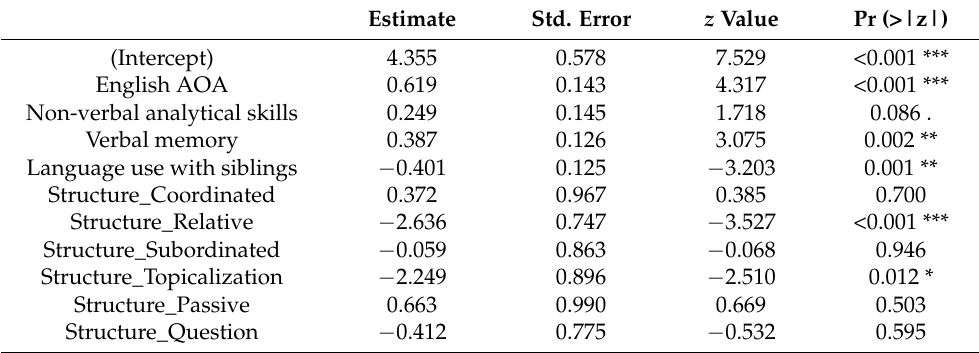
Table A16. Syrian Arabic T2 fixed